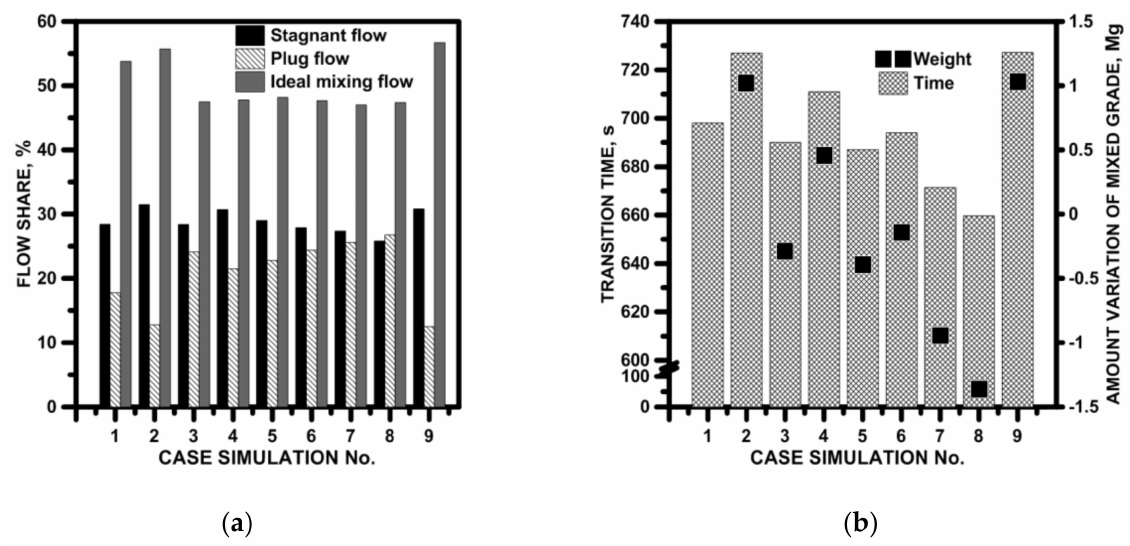
Figure 9. Hydrodynamics in the considered tundish with SFC: ( a ) active flow and stagnant flow, ( b ) transition